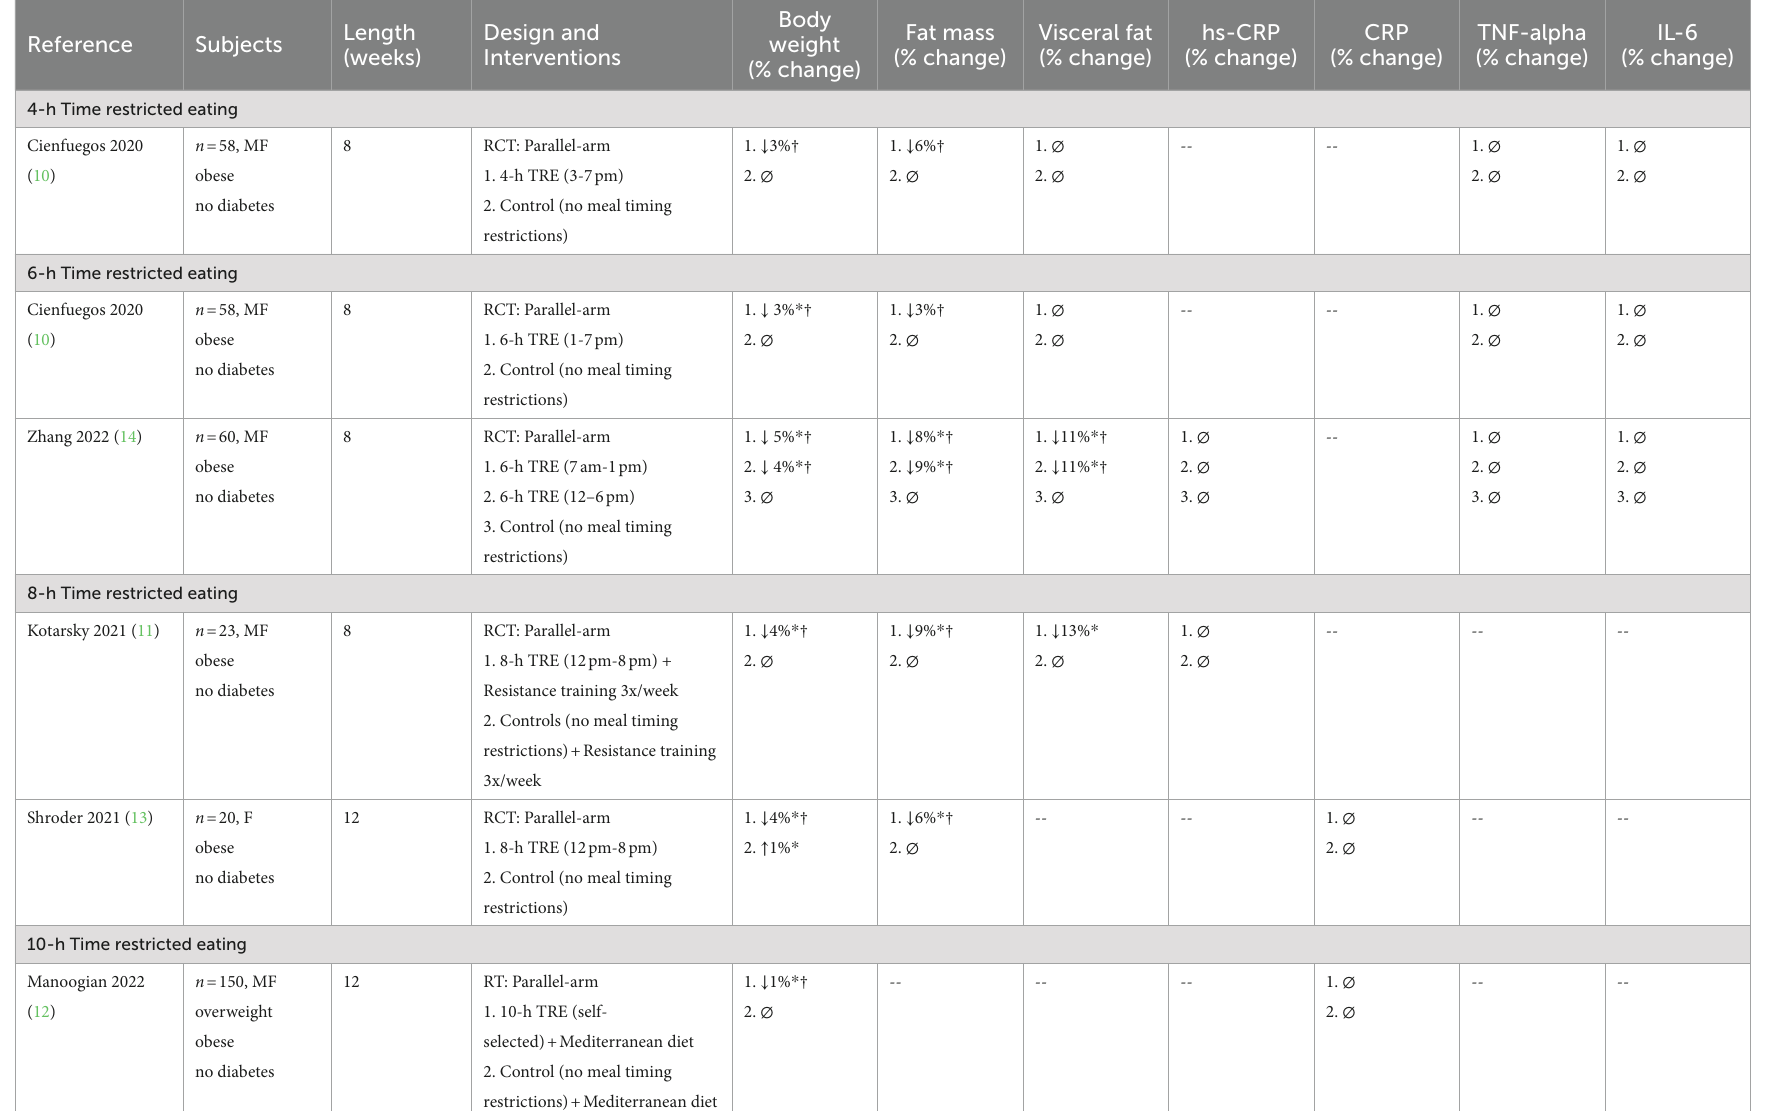
TABLE 1 Effect of time restricted eating on circulating inflammatory markers in adults with obesity.